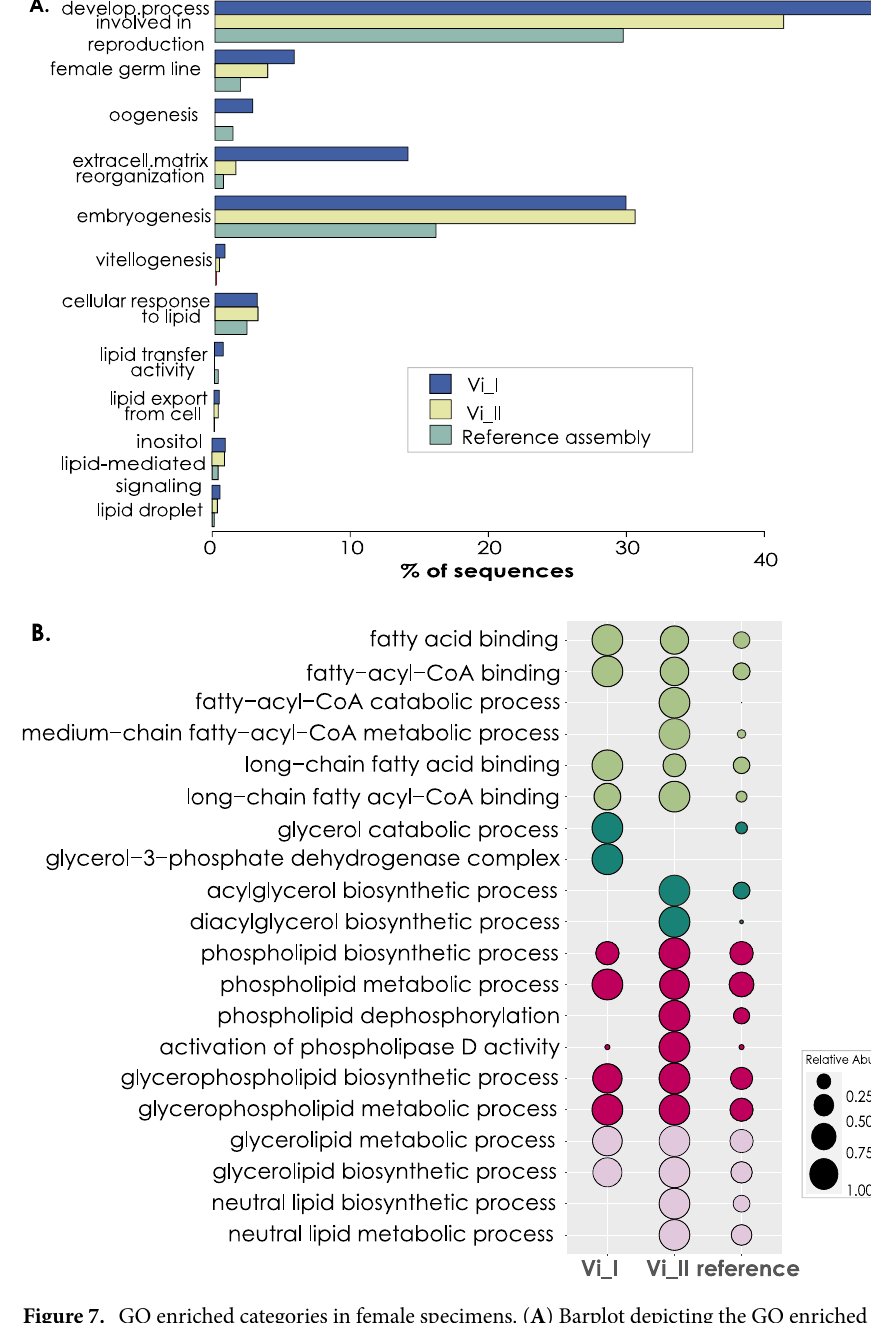
Figure 7. GO enriched categories in female specimens. ( A ) Barplot depicting the GO enriched categories related to oogenesis and female reproduction, based on the upregulated genes in females compared to nonreproductive individuals and the reference transcriptome. ( B ) Bubbleplot presenting GO enriched categories related to lipid metabolism derived from the upregulated genes in females compared to nonreproductive individuals. Each colour represents a different group of categories according to their function and the size of the circle in each case is relative to the expression level of this category. GO enrichment analysis was conducted selecting a p value ≤